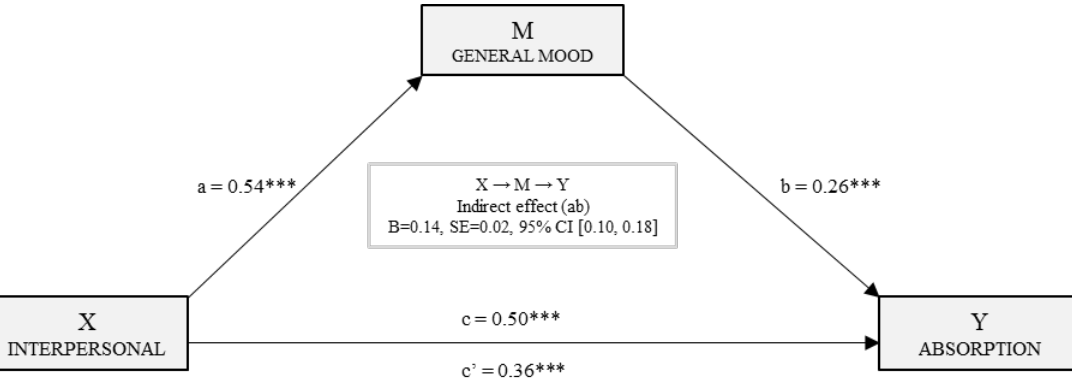
Figure 3. Simple mediation model of mood on the relationship between the interpersonal factor and the dedication dimension of engagement. (Note: *** p < 0.001).